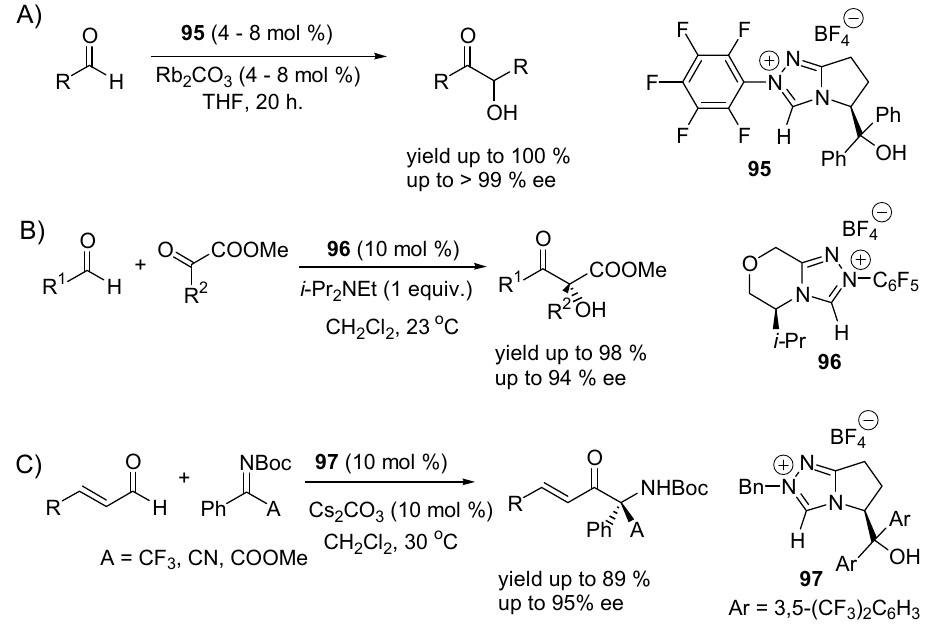
Scheme 50. Examples of enantioselective, intermolecular benzoin condensations. ( A ) Homobenzoin reaction; ( B ) cross ‐ benzoin reaction; ( C ) aza ‐ benzoin reaction.